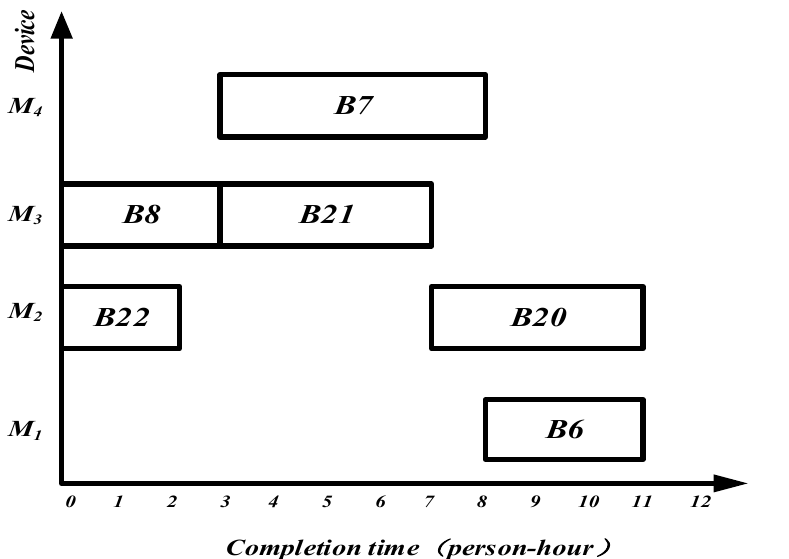
Figure 13. Gantt chart of operation string T B41 allocated to workshop f 2 with 11 person-hours.